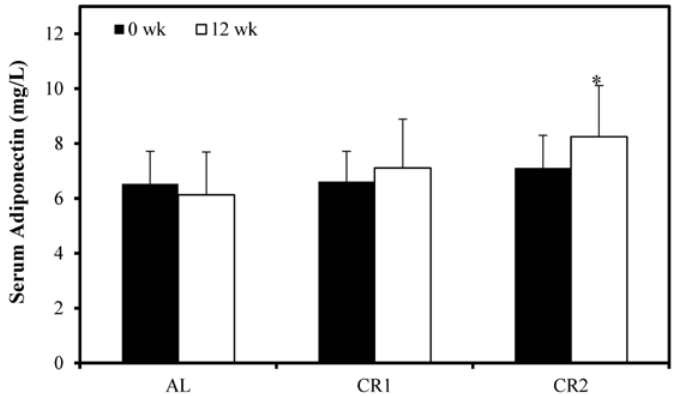
Figure 3. The effect of calorie restriction on serum adiponectin. Serum adiponectin